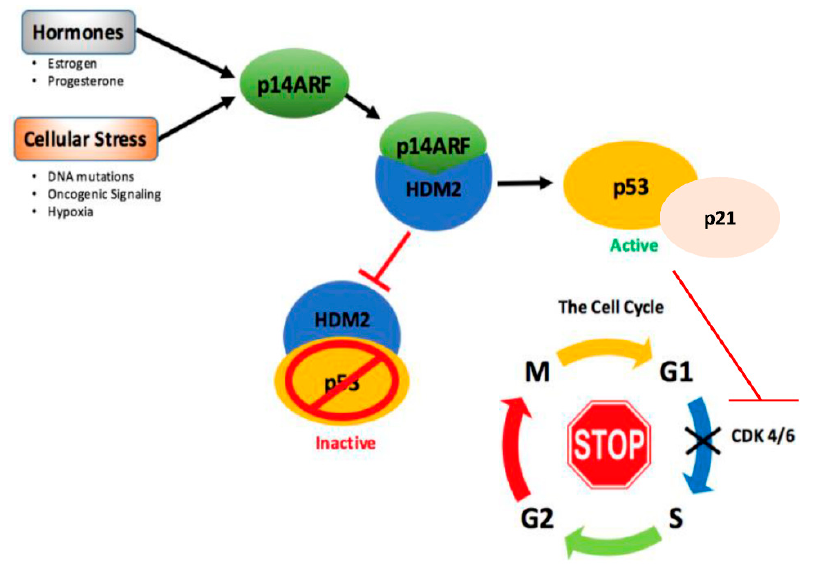
Figure 4. The p14ARF-p53 pathway. HDM2 sustains low basal levels of p53 by its continuous degradation [160,161]. p14ARF, activated by cellular stress signals and potentially regulated by estrogen and progesterone hormones in the breast [93,168–171], causes inhibition of the HDM2–p53 complex, therefore stabilizing p53. p53 is able to bring about cell cycle arrest at the G1/S phase through the activation of the CDK inhibitor p21, which inhibits downstream CDK 4 and 6 [66,68,69]. Both CDK 4 and 6 are well-known mediators of G1/S cell cycle progression, hence their inhibition by p21 halts the cell cycle [66].